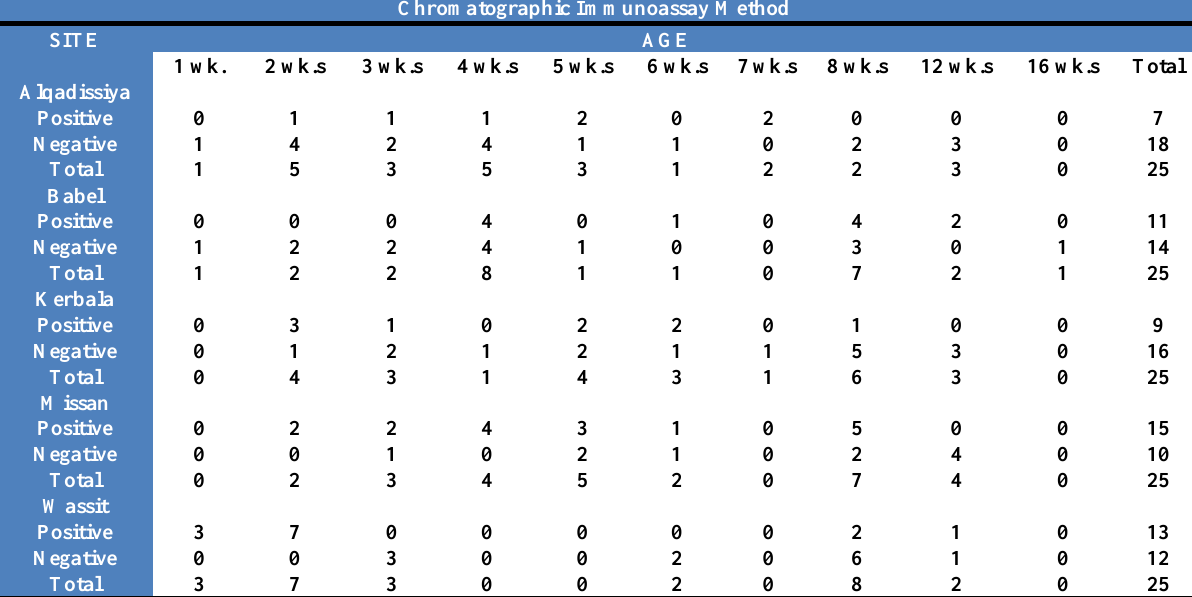
Table, 3: The results obtained by using Chromatographic Immunoassay method for Rotavirus in 125 fecal samples according to age of tested